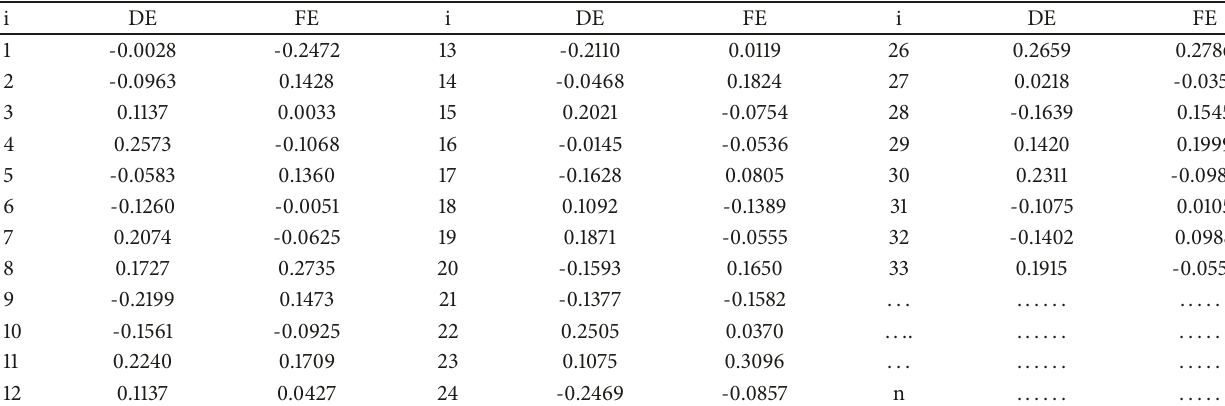
Figure 1: An experimental platform for fault simulation of motor bearing. Table 1: Partial drive end and fan end of bearing fault